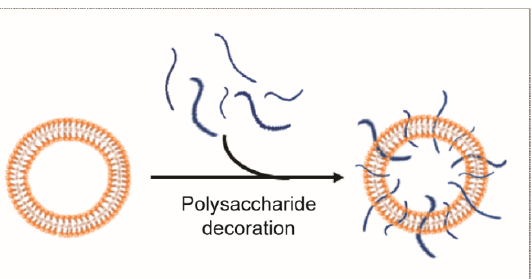
Figure 4. Polysaccharide decoration of EXO membrane. Graphical sketch illustrating the anchoring or integration of polysaccharides into EXO membrane for controlled biodistribution and circulation kinetics [105–110].